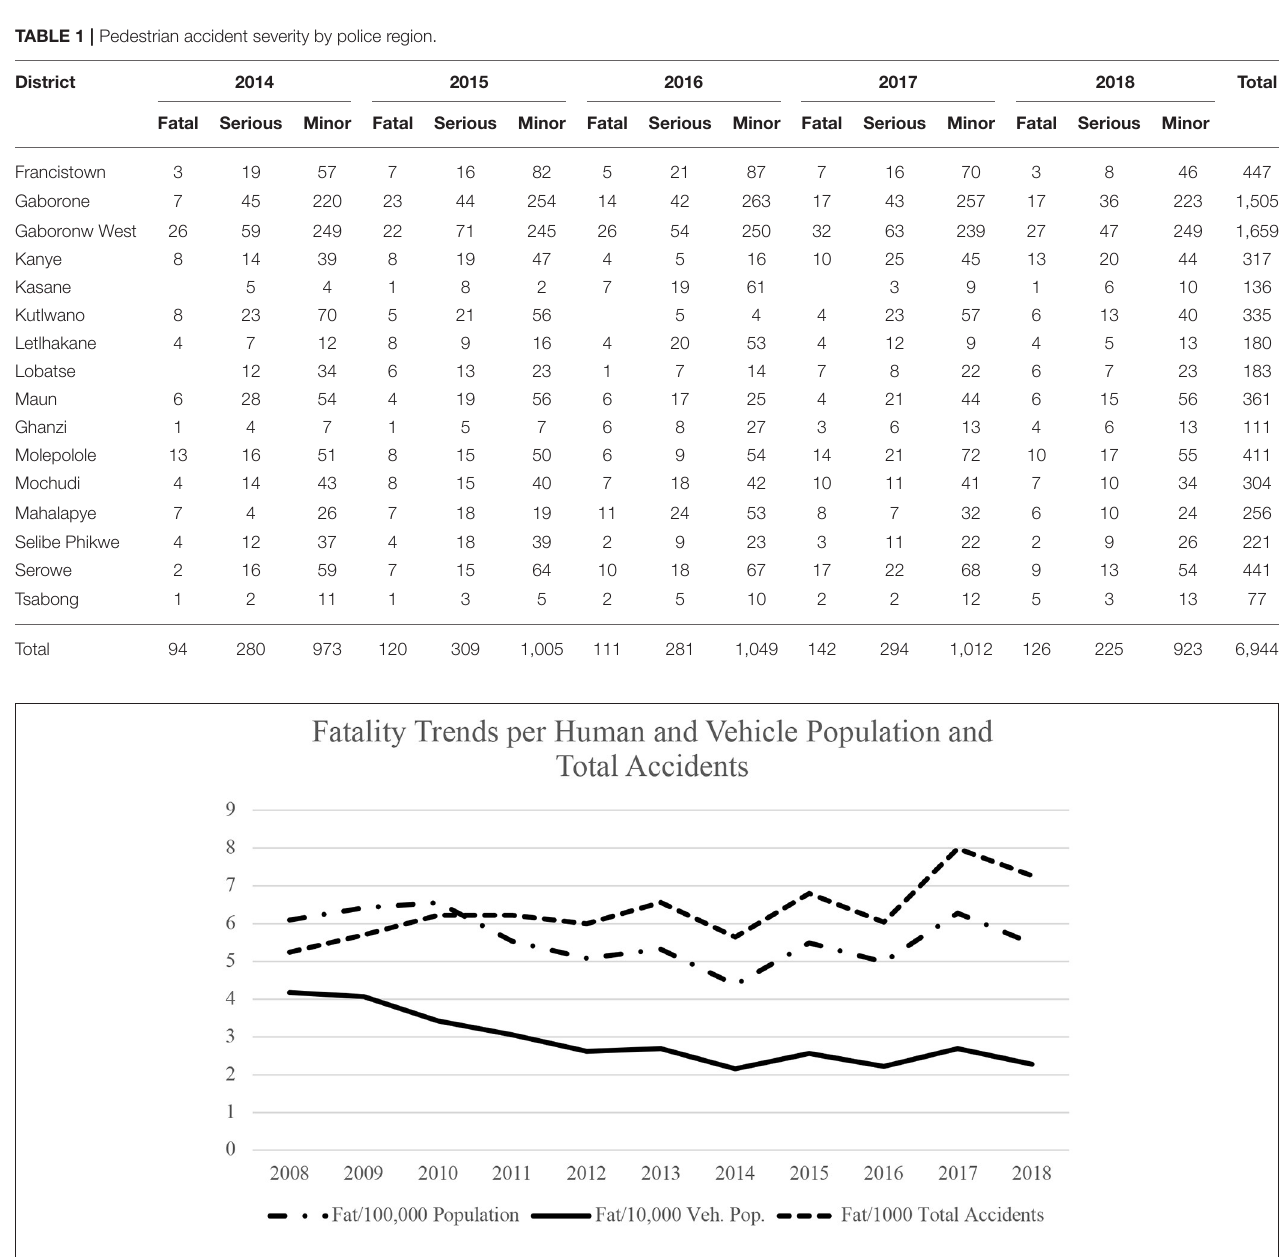
FIGURE 1 | Fatality trends per human and vehicle population, and total accidents. Source: